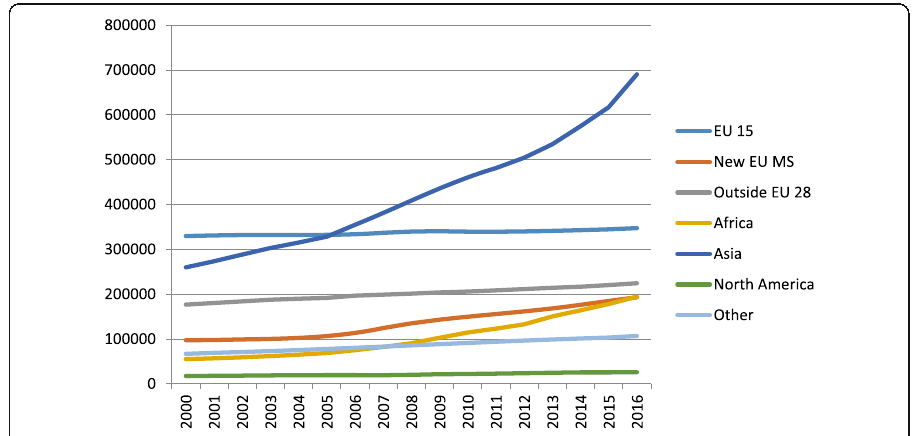
Fig. 2 First-generation immigrant population in Sweden, 2000 – 2016, by broad area of origin. Source : Statistics